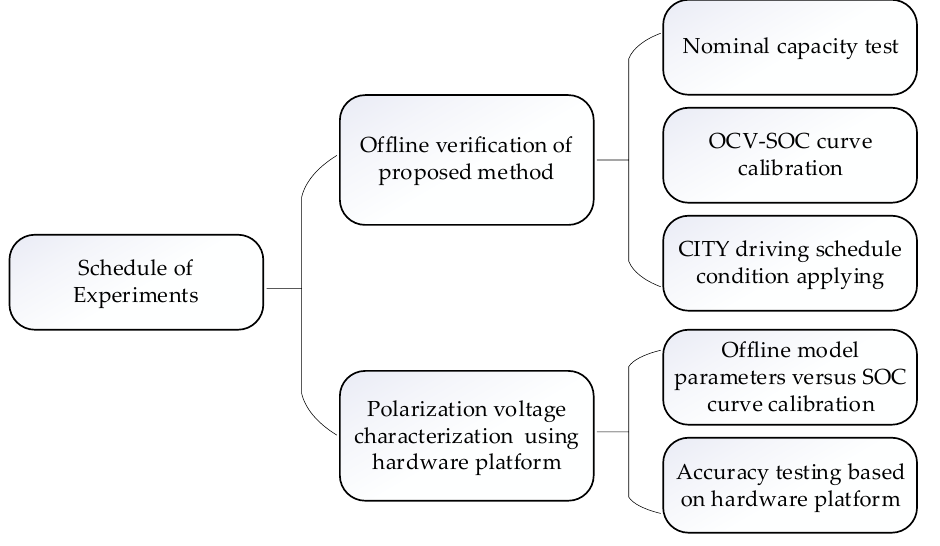
Figure 4. Schedule of experiments.